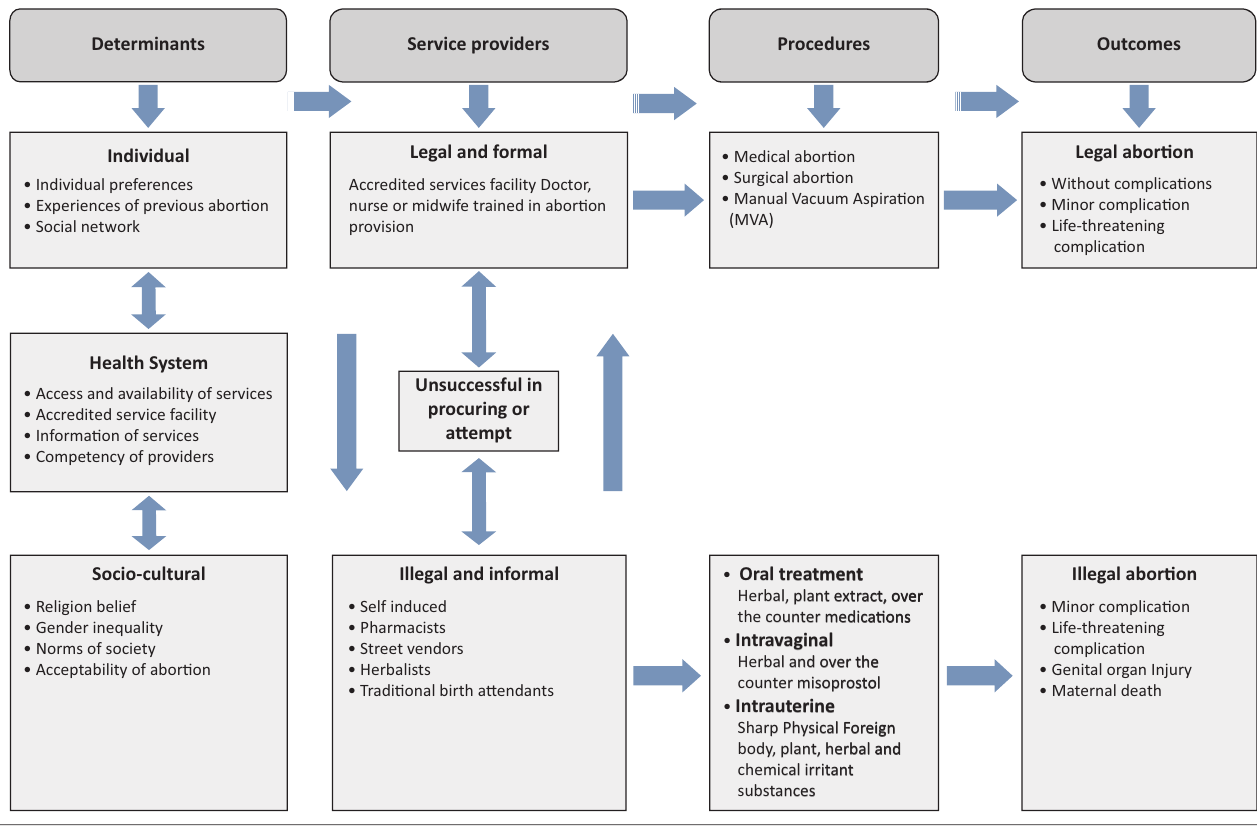
FIGURE 1: Conceptual framework for women’s abortion-related healthcare